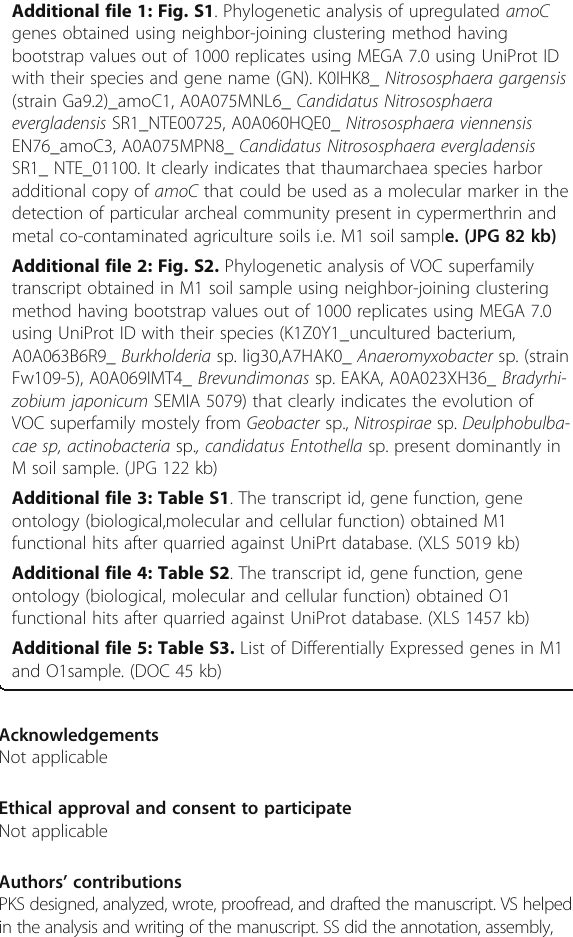
Additional file 3: Table S1 . The transcript id, gene function, gene ontology (biological,molecular and cellular function) obtained M1 functional hits after quarried against UniPrt database. (XLS 5019 kb) Additional file 4: Table S2 . The transcript id, gene function, gene ontology (biological, molecular and cellular function) obtained O1 functional hits after quarried against UniProt database. (XLS 1457 kb) Additional file 5: Table S3. List of Differentially Expressed genes in M1 and O1sample. (DOC 45